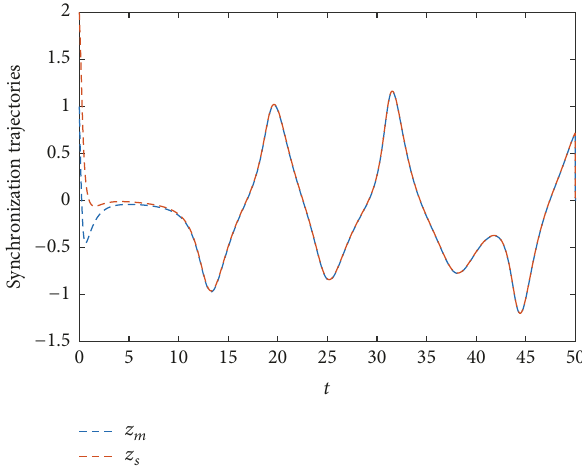
depicted in Figure 2. The state synchronization trajectories of the master-slave systems are shown in Figures